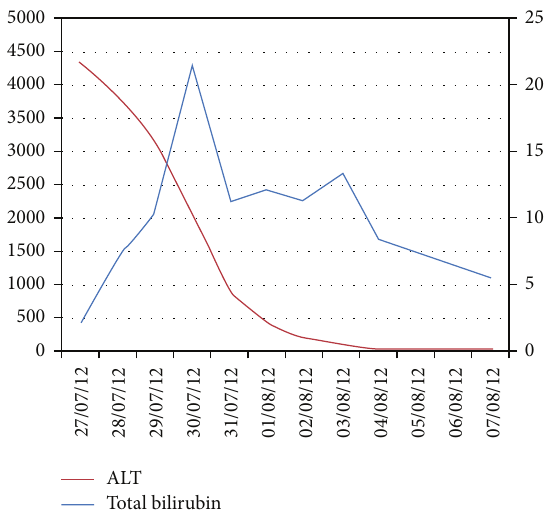
Figure 2: Graphical illustration of ALT (on the left axis) and serum bilirubin (on the right axis) over